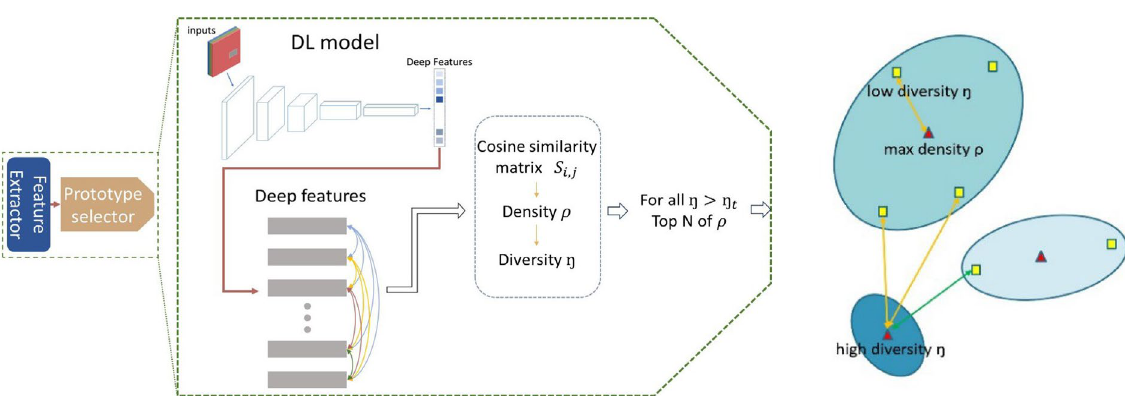
Figure 4. Prototype selection in each category. Left: The pipeline of prototype selection. Right: Measurements of density and